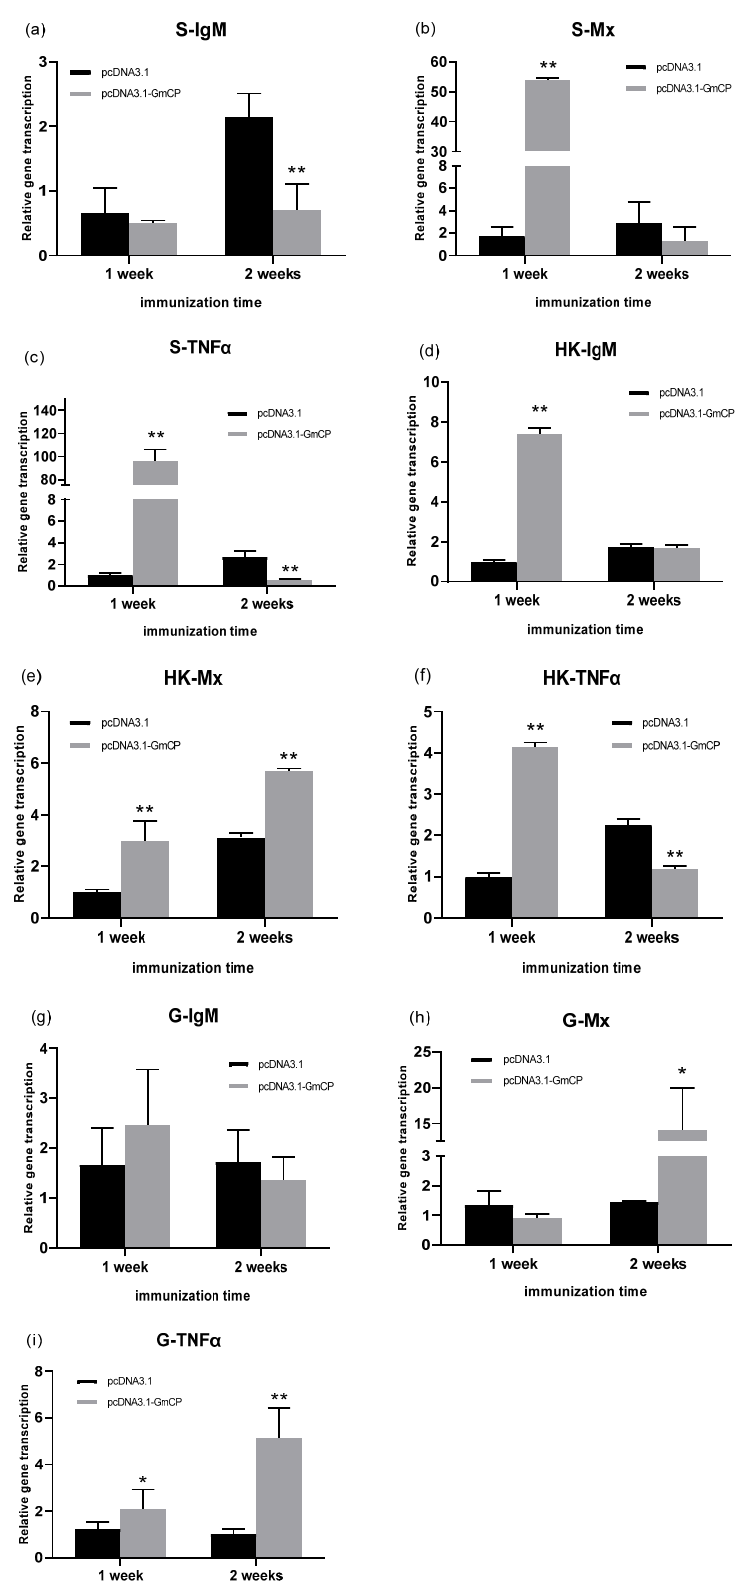
Figure 7. Expression of immune-related genes in different tissues after two injections of pcDNA3.1- CP (*: p < 0.05; **: p < 0.01). IgM, Mx and TNF- α in the spleen (S), head kidney (HK) and gill (G) were tested separately using qPCR (from ( a ) to ( i )).